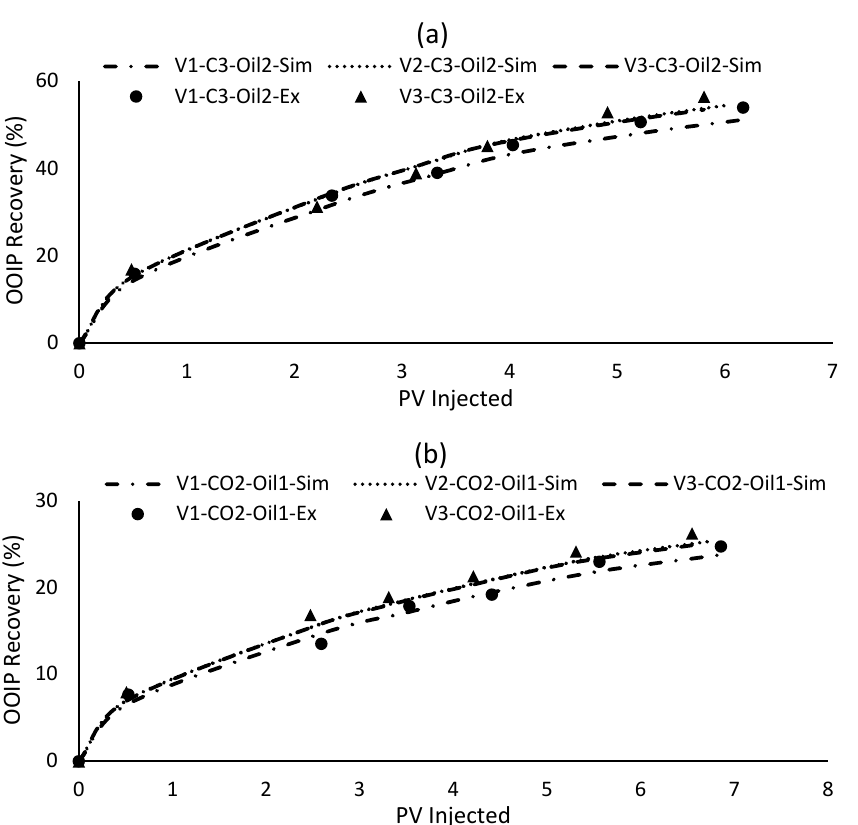
Figure 17. The effect of fracture intensity on the recovery factors in conventional VAPEX and patterns V1, V2, and V3 using propane ( a ) and carbon dioxide ( b ).